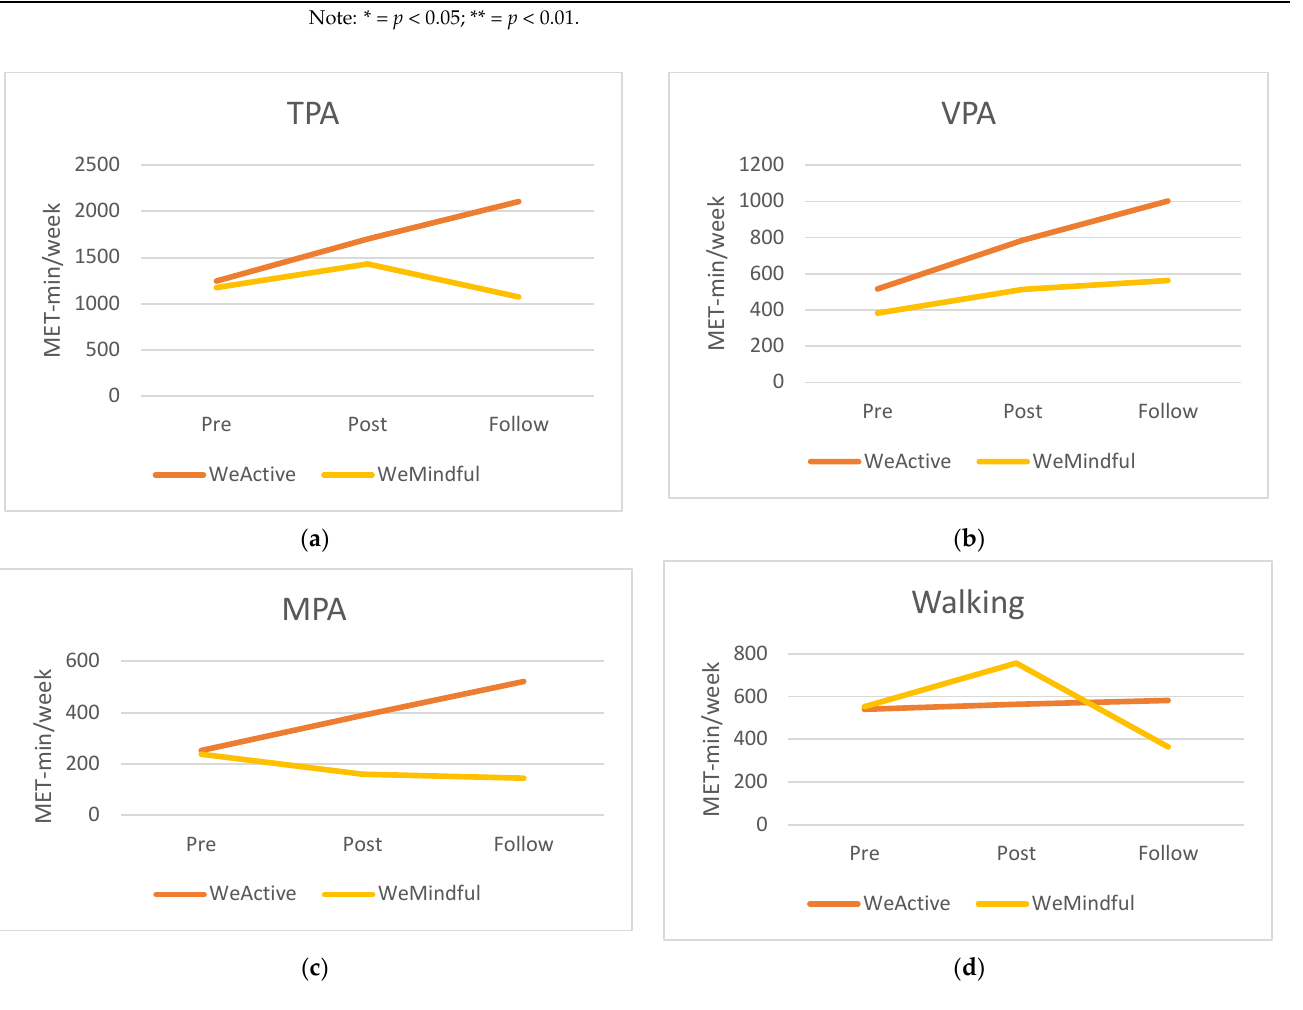
Figure 1. Descriptive statistics for both groups: ( a ) TPA; ( b ) VPA; ( c ) MPA; ( d ) walking. Table 4. Results of post hoc tests for all PA variables for the WeActive